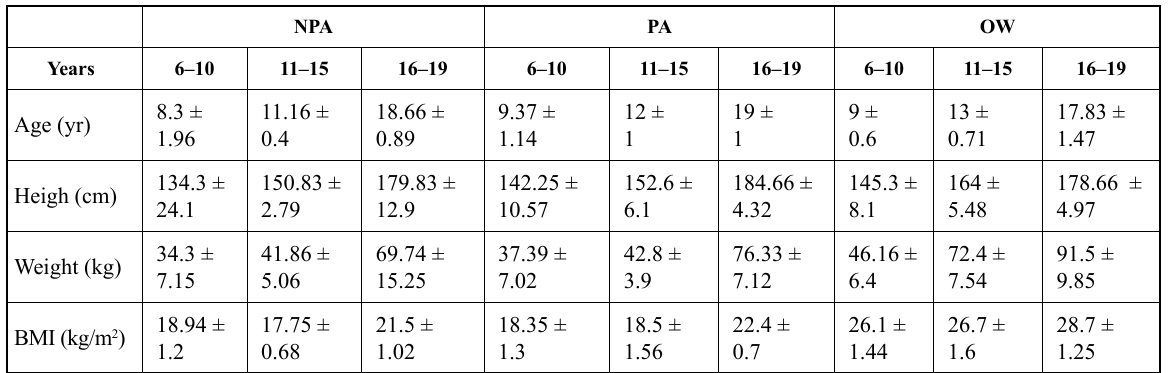
Table 1. Participants’